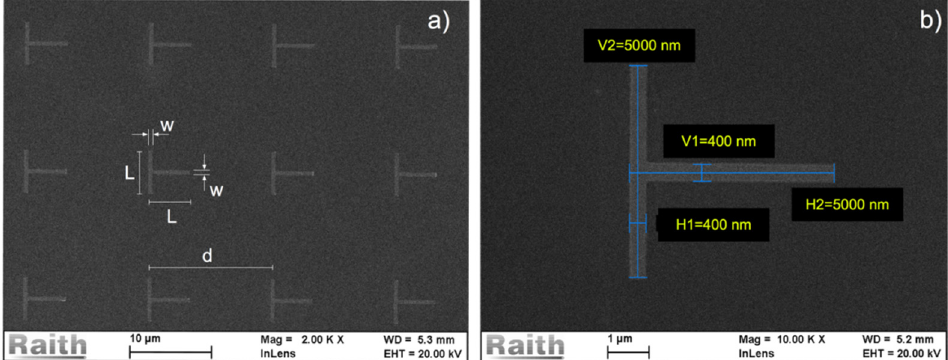
Figure 1. ( a ) SEM image of the array of T-shaped structures after lift-off showing the arm length L = 5 μ m, arm width w = 400 nm and inter structure distance d = 15 μ m. ( b ) Dimensions H1 = 400 nm, V1 = 400.0 nm, H2 = 5000 nm, V2 = 5000 nm of one individual T-shaped structure after lift-off measured with SEM.